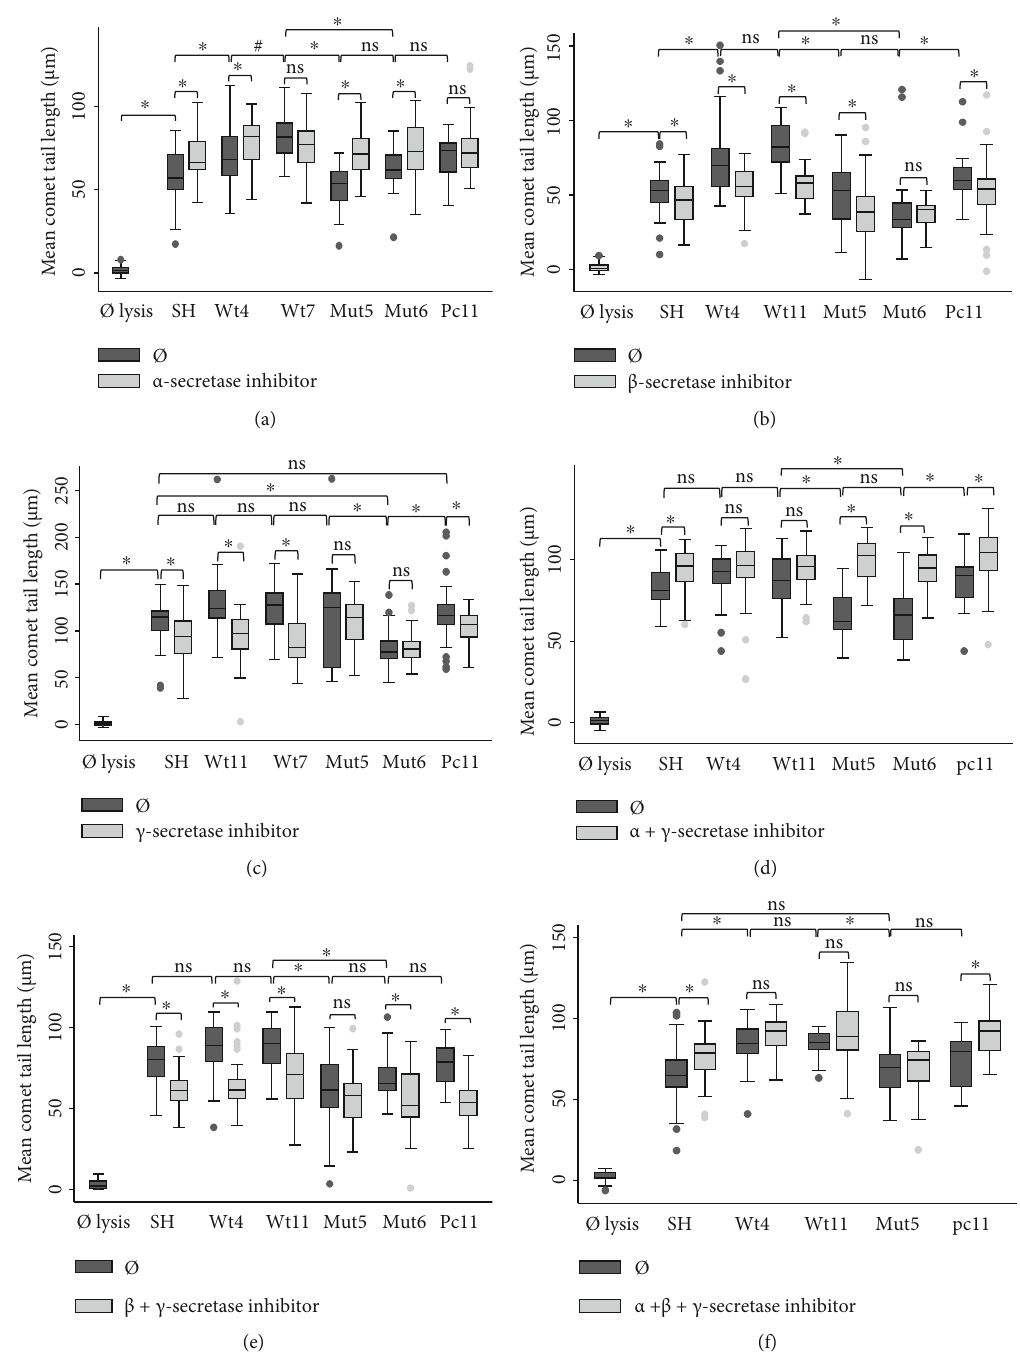
Figure 3: Comet tail lengths (in μ M) or DNA double-strand breaks (DSBs) and the β -amyloid cascade. The cleavage of APP was altered by (a) an α -secretase inhibitor (10 μ M, 1h), by (b) a β -secretase inhibitor (50nM, 1h), by (c) a γ -secretase inhibitor (13.5 μ M, 1h), or by a combination of inhibitors ((d) α - + γ -secretase inhibitors, 1h; (e) β - + γ -secretase inhibitors, 1h; and (f) α - + β - + γ -secretase inhibitors, 1h). The α -secretase inhibition generally resulted in increased DSBs, whereas the β -secretase and the γ -secretase inhibitions decreased DSBs mainly in the nonmutated cells. The α - + γ -secretase inhibitors resulted in increased DSBs, except in the Wt clones. The β - + γ -secretase inhibitors generally resulted in decreased DSBs, whereas the α - + β - + γ -secretase inhibitors resulted in no DSB changes in the Wt and the Mut clones. Number of cells measured: 19 < n < 47 . ANOVA with Bonferroni test: ∗ p < 0 : 05 ; # p < 0 : 001 ; ns: nonsigni fi cant